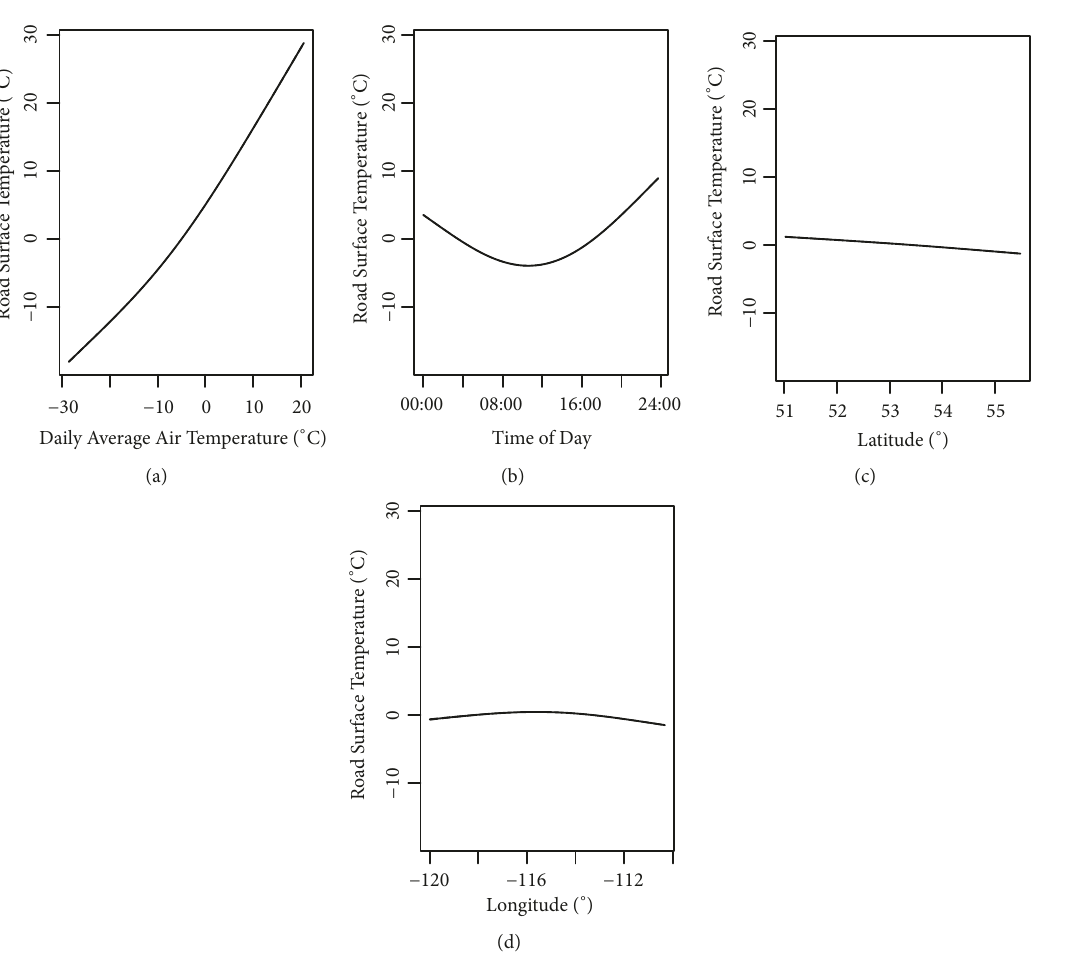
Figure 4: Nonlinear associations between RST and predictors. (a) Daily average air temperature.(b) Time of day. (c) Latitude. (d)